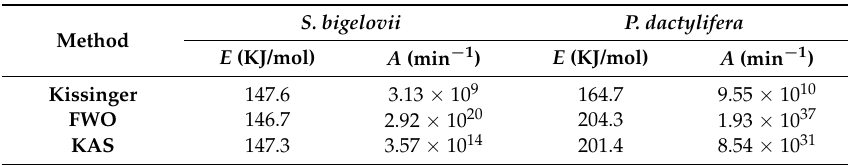
Table 1. Sumary of kinetic parameters E (kJ/mol) and A (1/min) for S. bigelovii , P. dactylifera by different